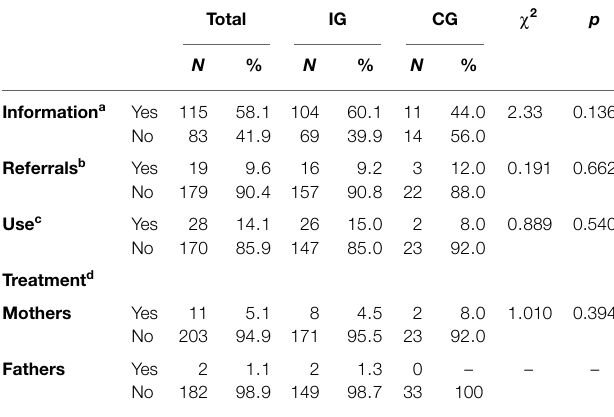
TABLE 7 | Information provided, referrals, and use, and inferential statistics .